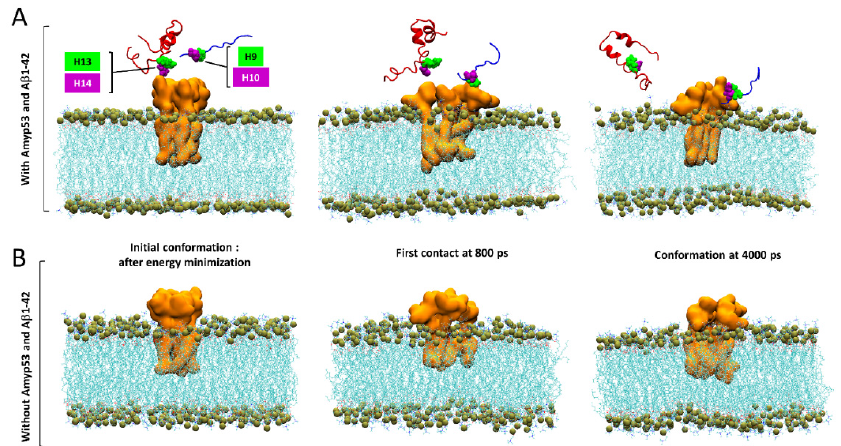
Figure 10. ( A ) Competition between AmyP53 and A β 1–42 for interacting with GM1 molecules in front view. ( B ) Conformational landscape of GM1 molecules without AmyP53 and A β 1–42 . AmyP53 is depicted as blue cartoon while A β 1–42 is depicted as red cartoon.